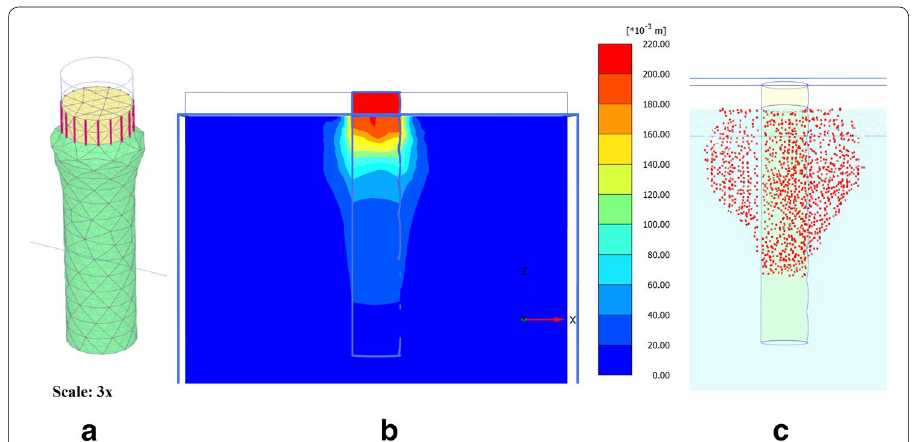
Fig. 2 Column with C u column; c plastic